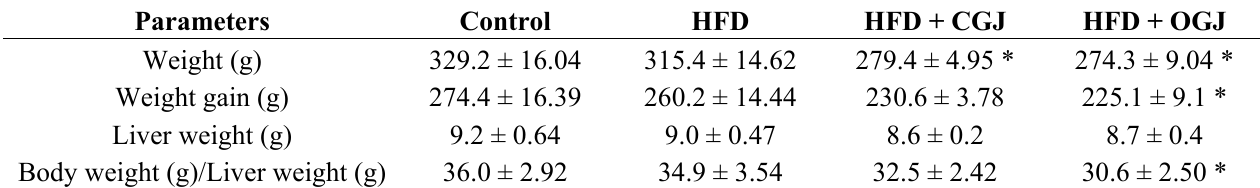
Table 1. Body and liver weight studies of animals treated with a high-fat diet (HFD), conventional grape juice (CGJ) and organic grape juice